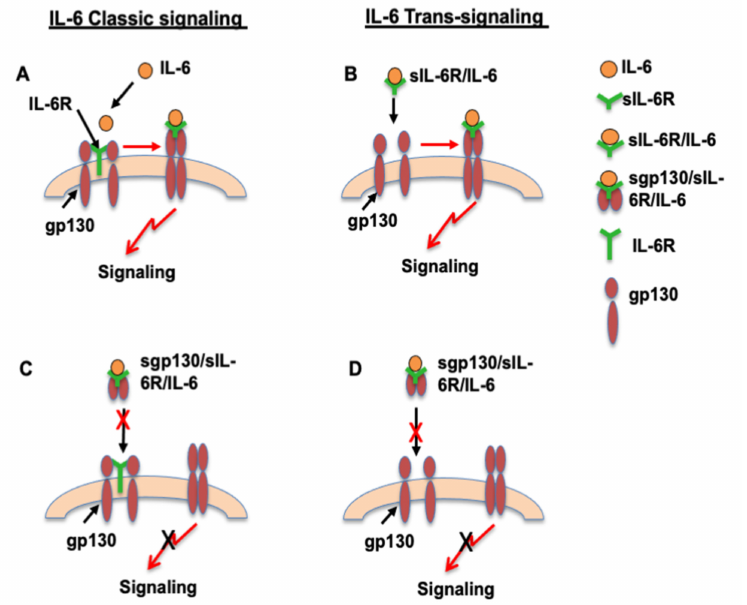
Figure 3. Proposed differences in IL-6 classic signaling and IL-6 trans-signaling in neutrophils and endothelial cells. IL-6 classic signaling in neutrophils ( A ) and trans-signaling in endothelial cells ( B ) in unstimulated condition. A: IL-6 classic signaling in neutrophils. Neutrophils have both IL-6R and gp130. IL-6 binds to IL-6R and then initiates gp130 trans-signaling. B: IL-6 trans-signaling in endothelial cells. Endothelial cells have gp130, but not IL-6R. sIL-6R/IL-6 complex binds to gp130 and then initiates gp130 trans-signaling. C and D: Proposed dysregulation of IL-6 classic signaling in neutrophils ( C ) and trans-signaling in endothelial cells ( D ) in preeclamptic condition. Increased sgp130 production and increased sgp130/sIL-6R/IL-6 complex formation could prevent IL-6 to bind to IL-6R in neutrophils ( C ) and block sIL-6R/IL-6 to bind to gp130 in ECs, as a result, blocks gp130